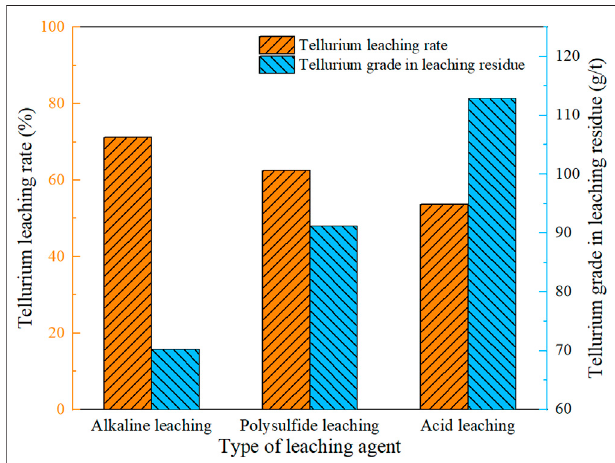
FIGURE 2 | Effect of leaching agent type on tellurium leaching rate.